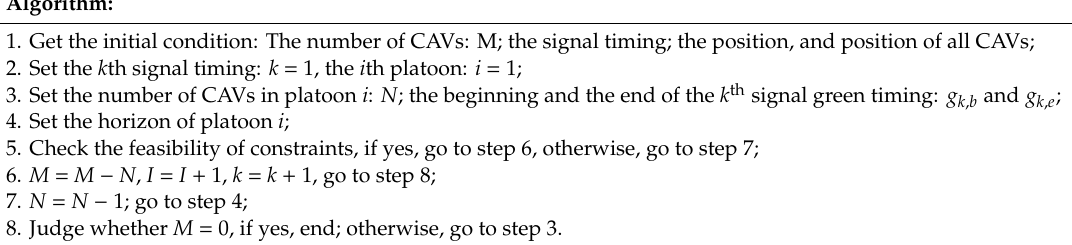
Table 3. Sub-platoon splitting algorithm.